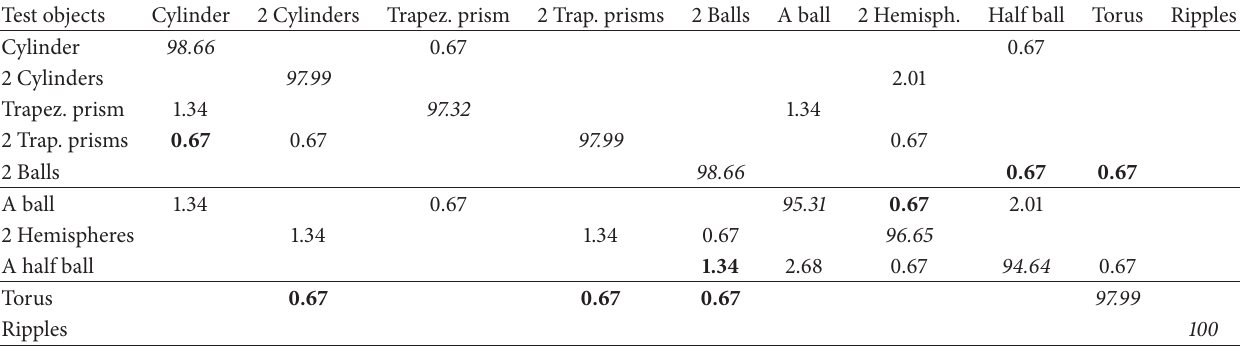
Table 1: Confusion matrix of the virtual shapes recognition and identification (%) in the free scanning mode, averaged over all participants.